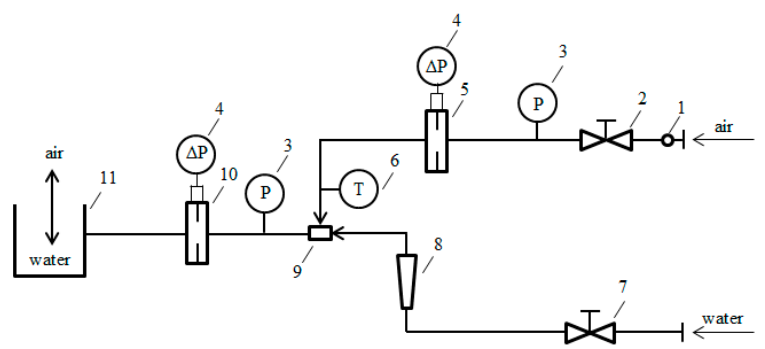
Figure 2. Diagram of experimental setup applied for research of flow rate of two-phase mixture: